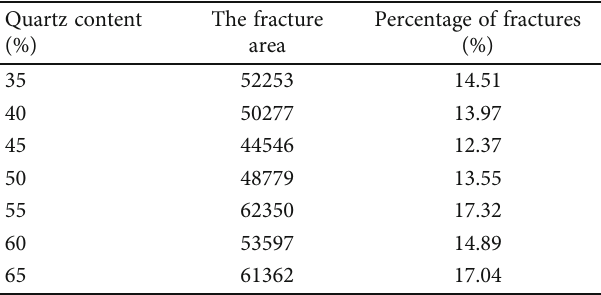
Figure 14: Schematic diagram of the fracture process, acoustic emission, and fracture skeleton of shale with di ff erent quartz Table 4: Total amount and proportion of fractures in shale with di ff erent quartz contents.